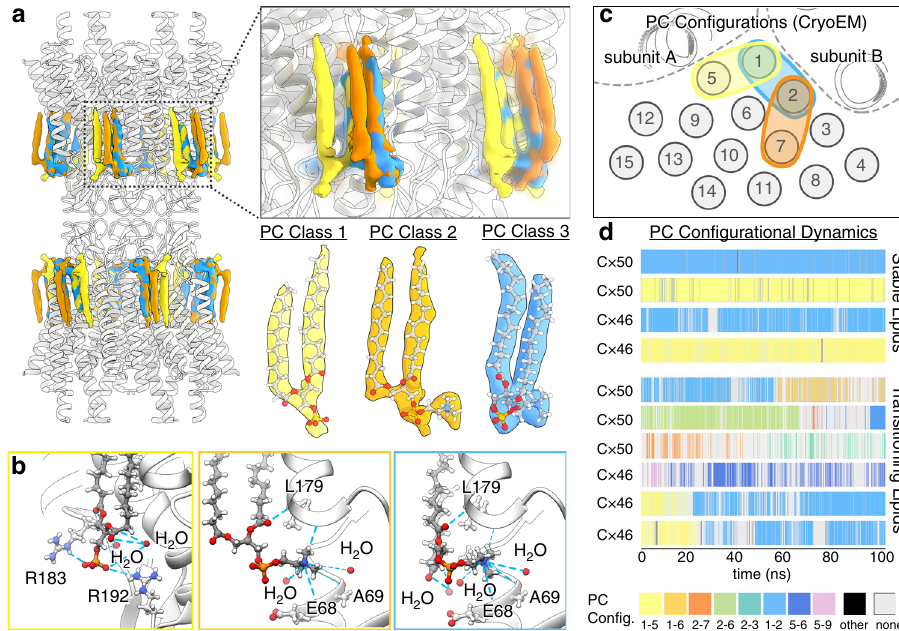
Fig. 4 PC lipid con fi gurational heterogeneity and dynamics resolved by CryoEM and MD. a Segmented phosphatidylcholine (PC) density maps obtained by CryoEM 3D heterogeneity analysis and classi fi cation (PC Class 1 — yellow, PC Class 2 — orange, PC Class 3 — blue). Insets show a zoom view displaying the overlapping features of resolved lipid con fi gurations and segmented densities with fi tted atomic models obtained from the three PC classes. CryoEM density for all other non-unique acyl-lipid chains, with unresolved head groups, have been omitted for clarity. b Zoom view showing Cx50 hydrogen bond interactions (blue dashed line) between the PC lipid head group and phospho-glycerol backbone. Interacting amino acids and stabilized water molecules are labeled. Yellow box — PC Class 1, orange box — PC Class 2, blue box — PC Class 3. c Illustration showing acyl-chain positions and con fi gurational assignments resolved by CryoEM (represented as gray circles and numbered 1 – 15). d PC con fi gurational classi fi cation and dwell times obtained by all-atom MD simulation, showing representative populations of stable (non-transitioning) and dynamic (transitioning) lipids. PC con fi gurations were classi fi ed by acyl-chain occupancy in densities numbered as in c and colored uniquely (as indicated, bottom of d